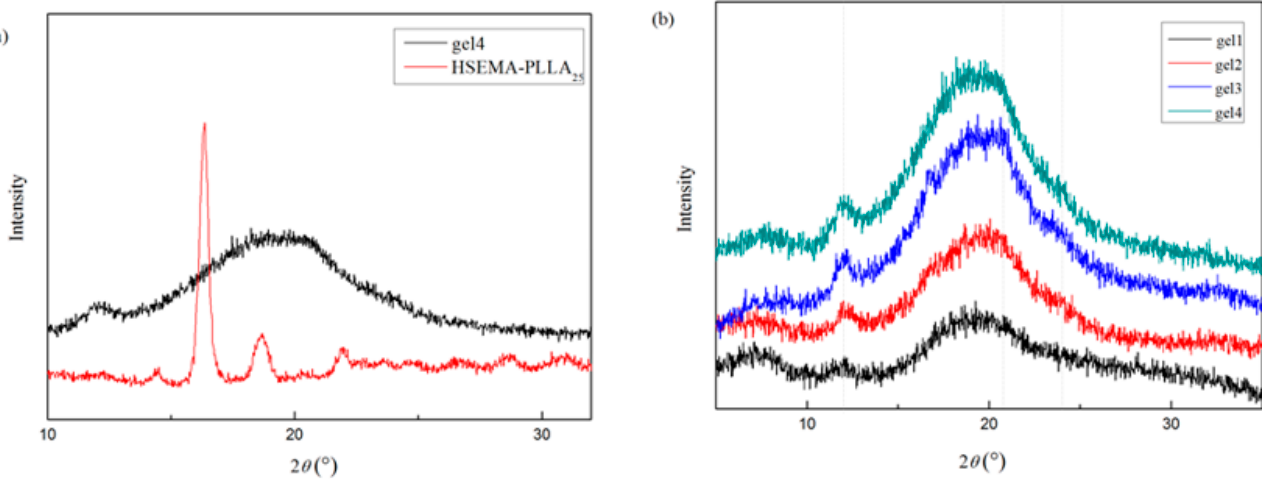
Figure 4. WXRD patterns of ( a ) macromonomer HSEMA-PLLA 25 and gel4, ( b ) gels with different polymerization degrees of PLA.